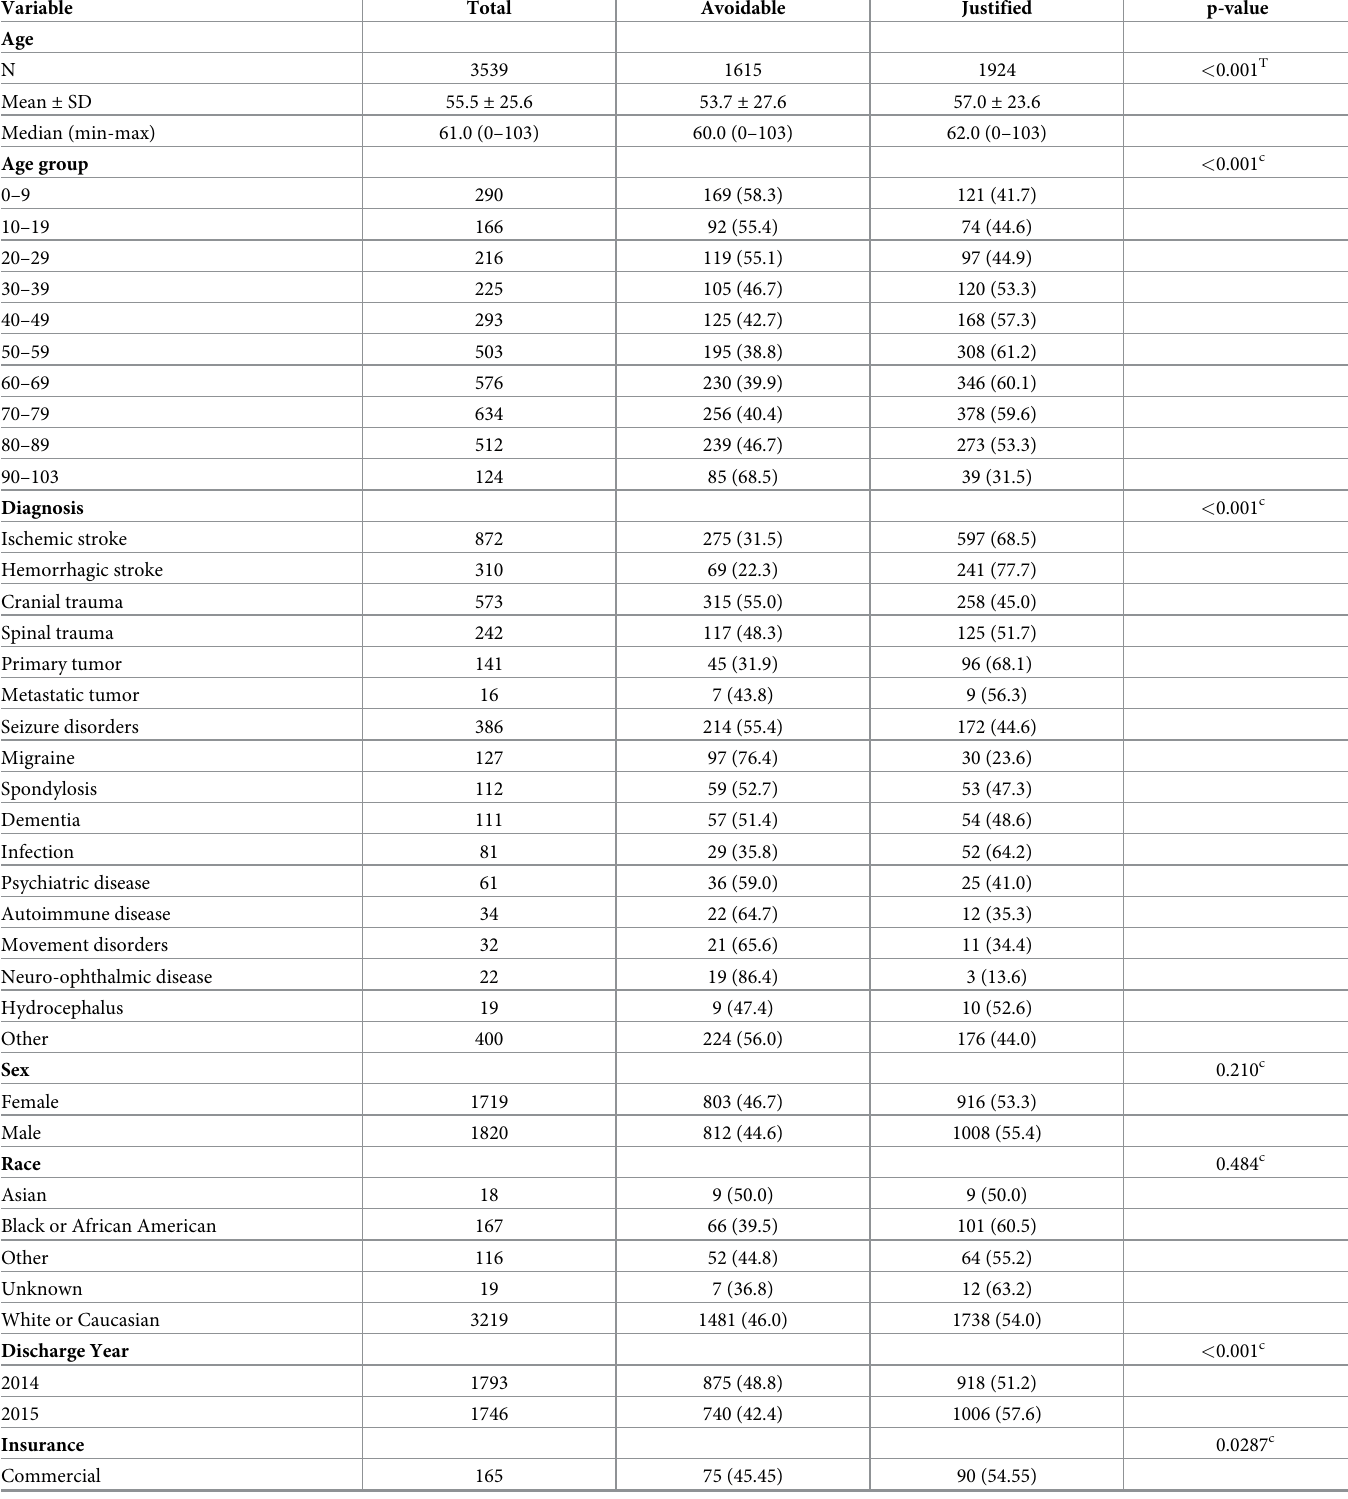
Table 1. Potentially avoidable transfers: Patient sociodemographic and hospital